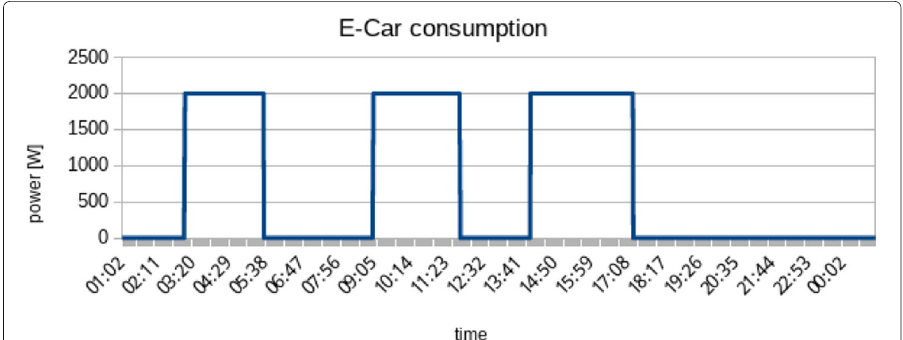
Listing 1 Generated EV battery charging